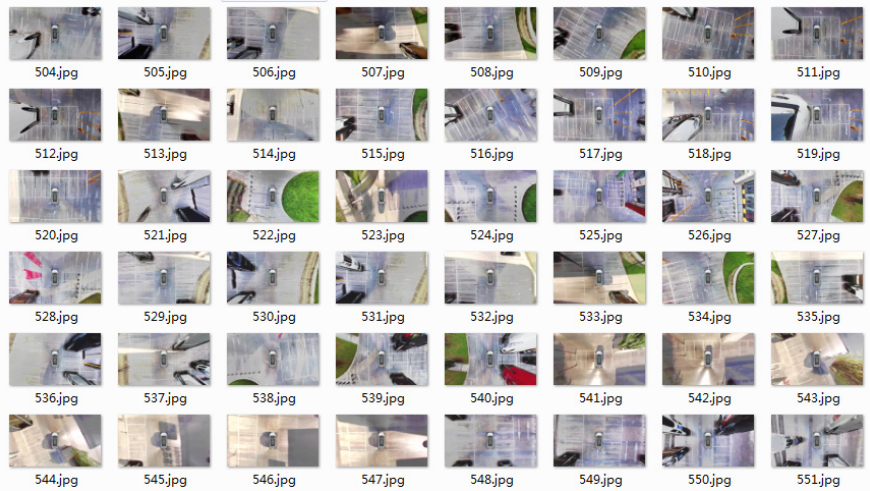
Figure 14. Valid images.